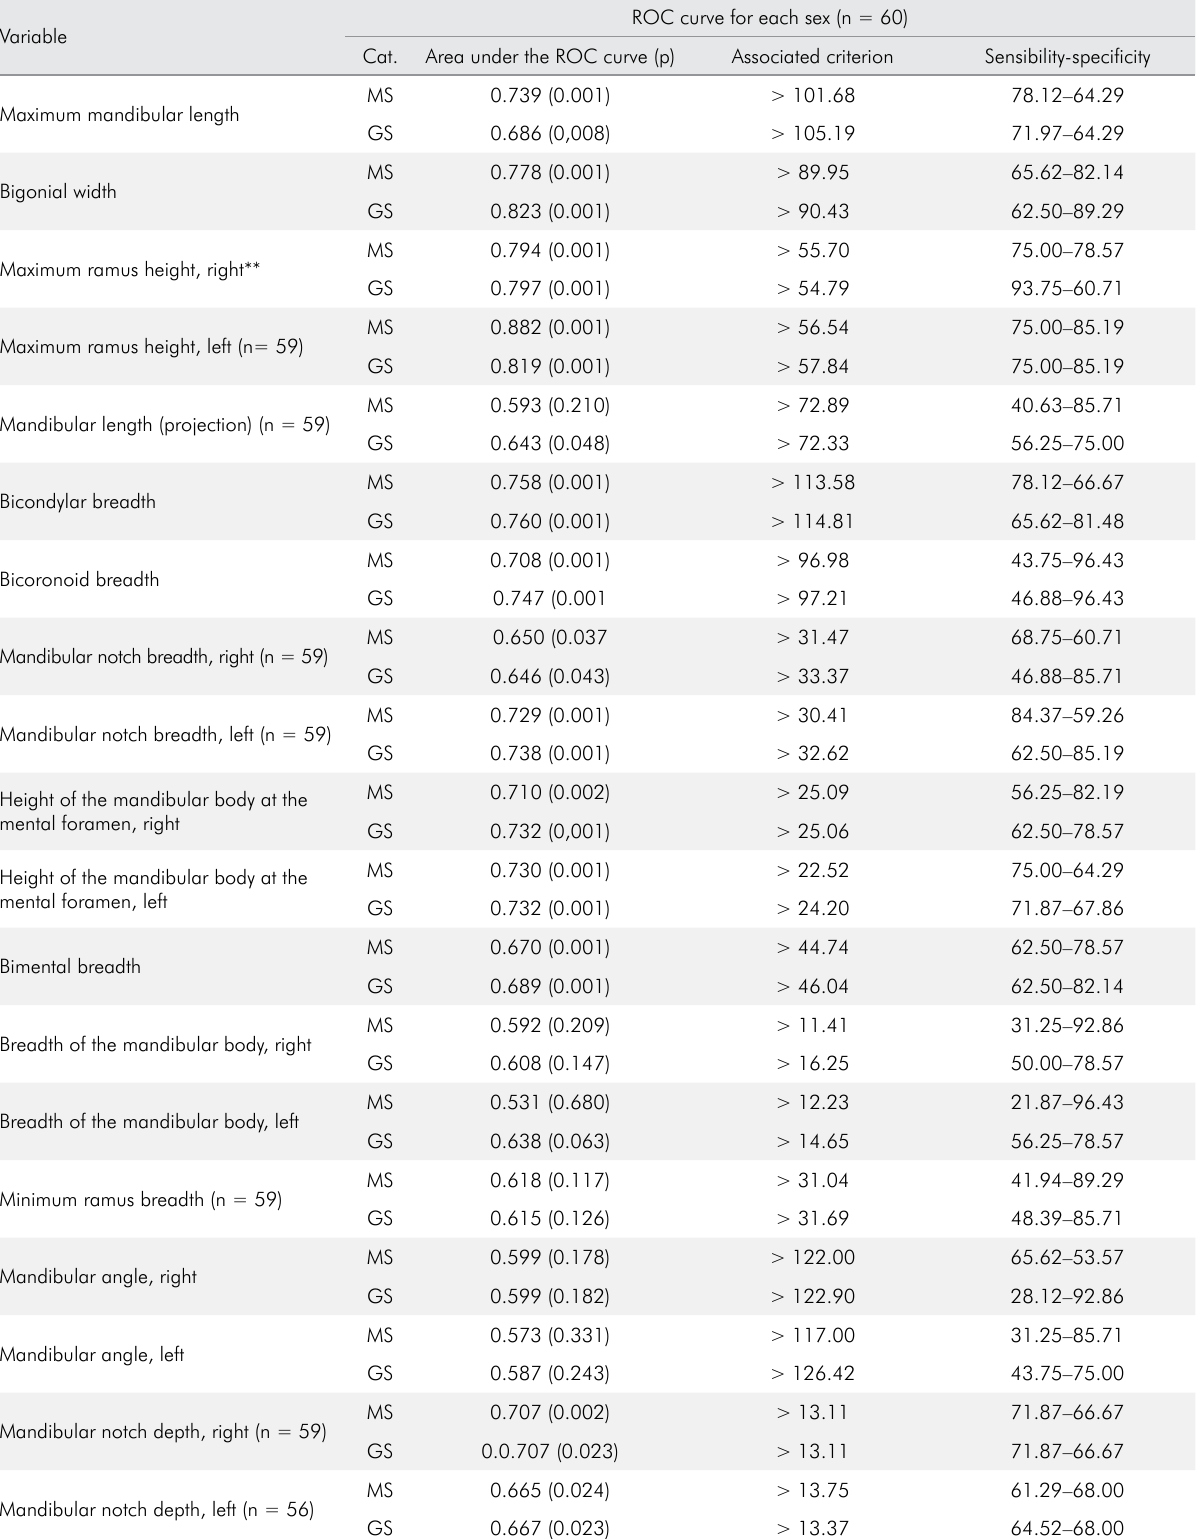
Table 5. ROC curve of the measurements using the mandible stabilizer (MS) and the tomographic measurements (GS, golden standard) for each